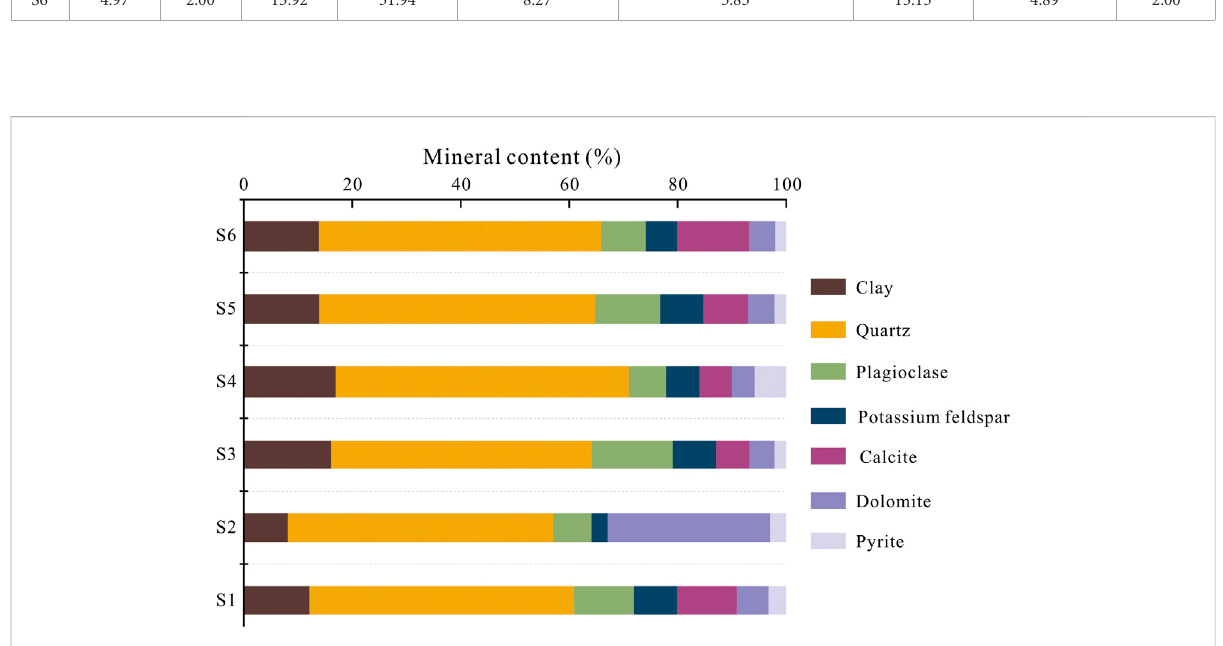
FIGURE 2 The mineral content of the shales identi fi ed by XRD